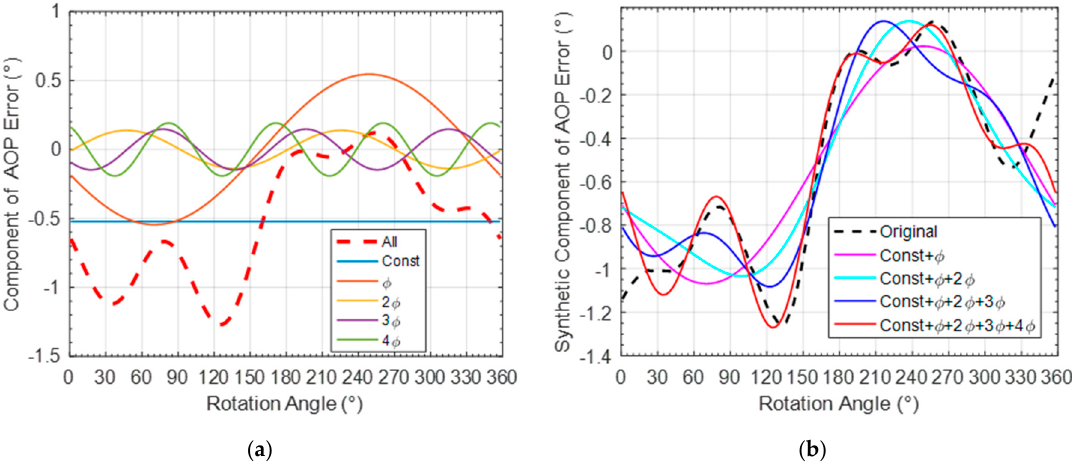
Figure 14. Spectral analysis of the outdoor AOP error. ( a ) spectrum component; ( b ) synthetic component of AOP error.